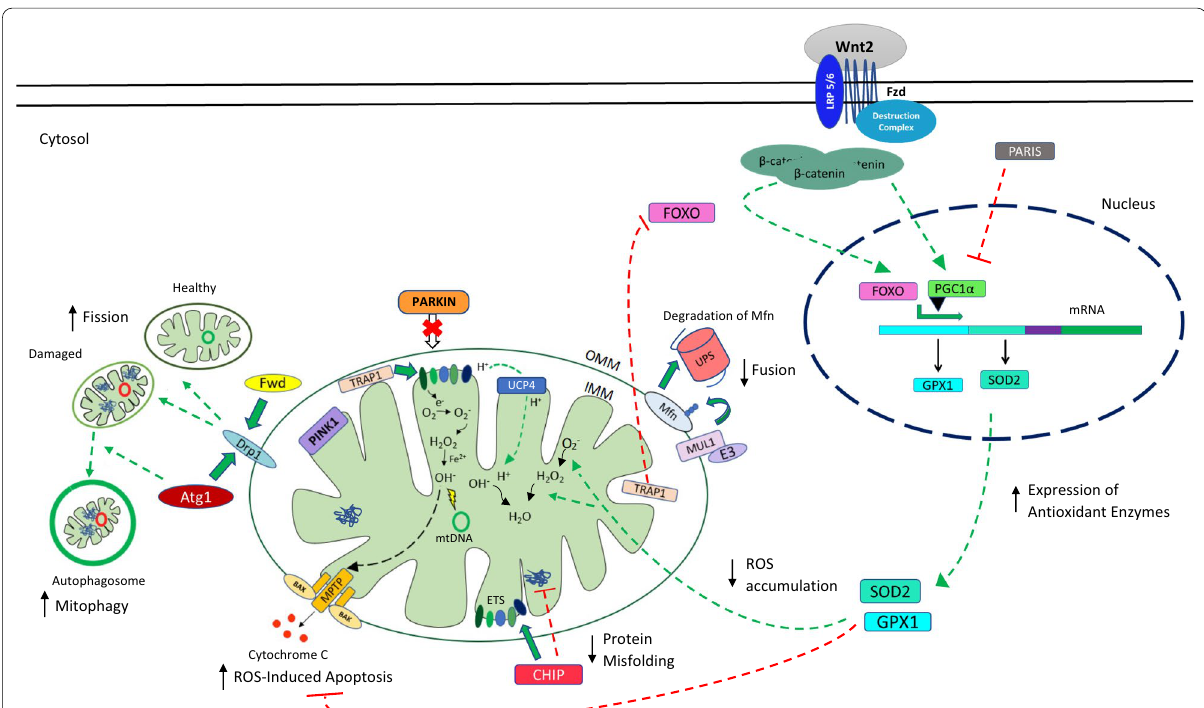
Fig. 1 A summary of the molecular rescues for PINK1/PARKIN loss of function. In the event of PINK1/Parkin loss of function, PINK1 remains embedded in the inner mitochondrial membrane with impaired kinase activity thus unable to phosphorylate PARKIN for translocation to the mitochondria. Respiratory complexes (ETS) drive the reactive oxygen species (ROS) cascade. ROS modify mitochondrial DNA and induce cytochrome C release to trigger apoptosis. Uncoupling protein 4 (UCP4) enables the leakage of protons from the intermembrane space back